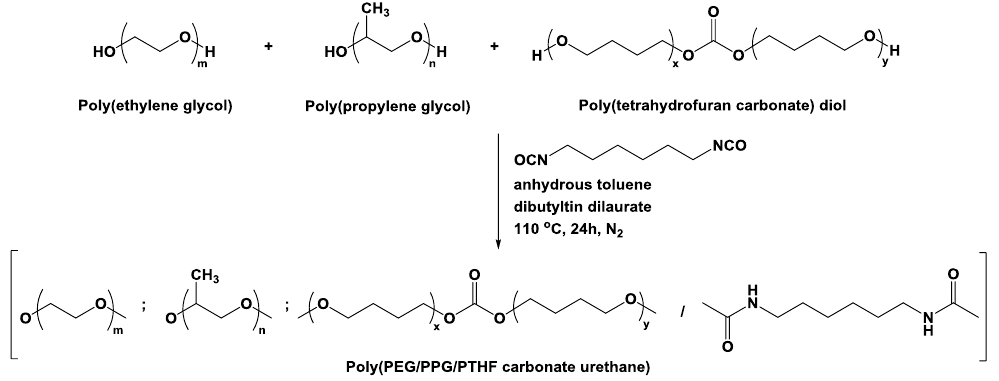
Figure 1. Schematic diagram depicting the synthesis process of poly(PEG/PPG/PTHF carbonate urethane)s.